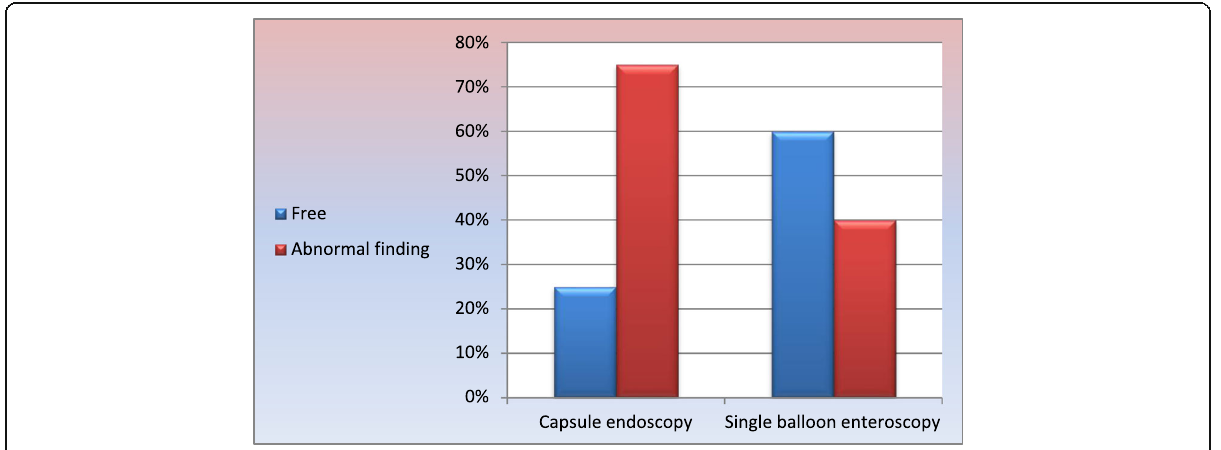
Fig. 3 Capsule endoscopy versus single-balloon enteroscopy in small-bowel